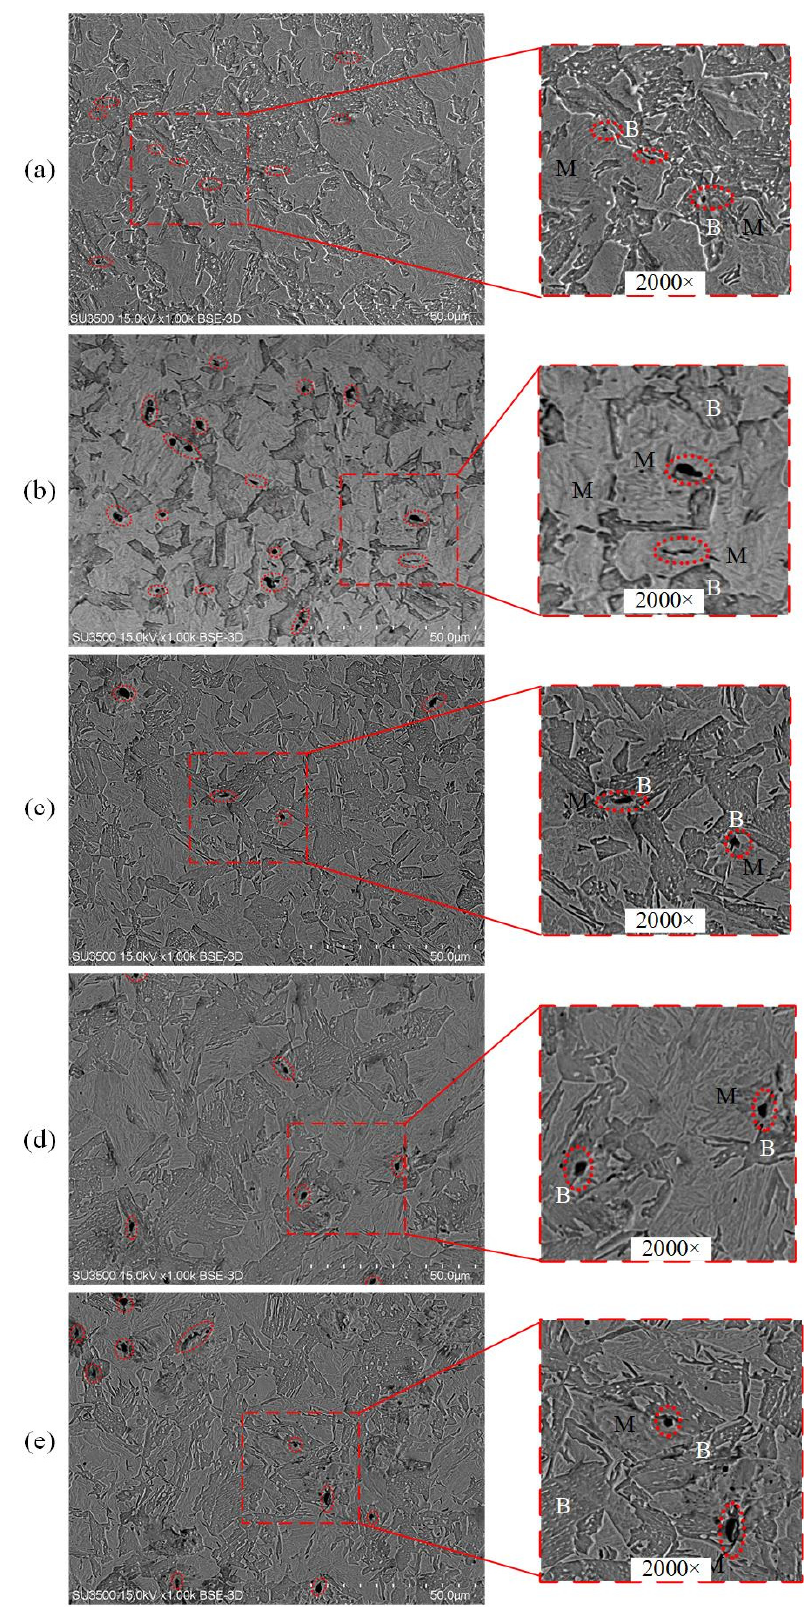
Figure 21. SEM micrographs showing void initiation and crack growth for 30%B + 70%M specimens under varying stress states: ( a ) pure shear specimen; ( b ) dogbone uniaxial tension specimen; ( c ) uniaxial tension specimen with a central hole; ( d ) plane strain tension specimen; ( e ) equi-biaxial tension specimen.